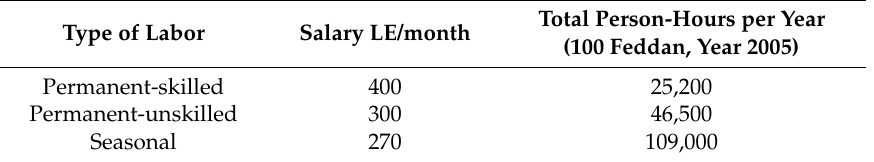
Table 13. Labor cost.